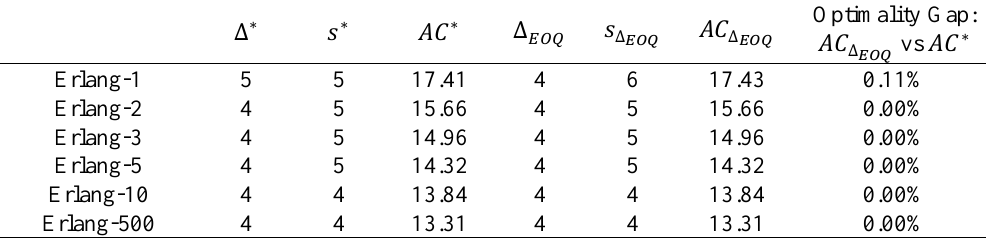
Table 6 . The impact of processing time